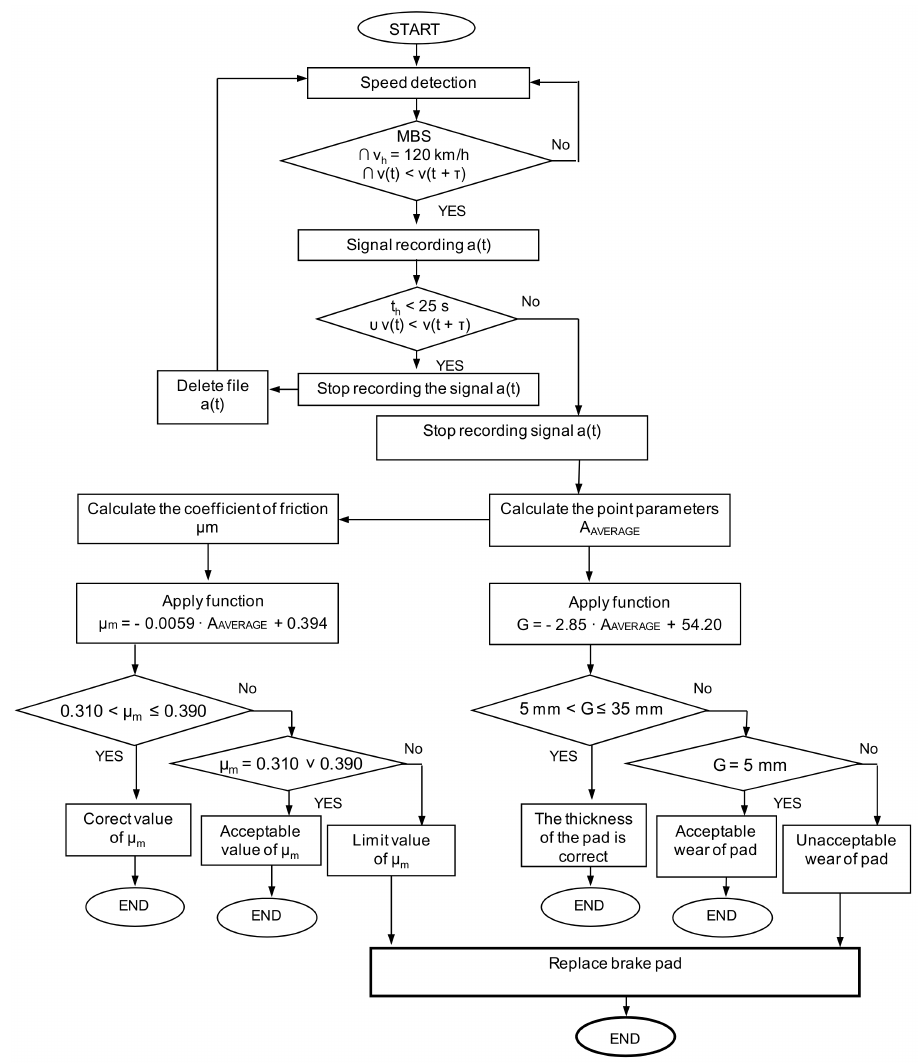
Figure 13. Algorithm of wear evaluation and estimation of the average coefficient of friction during braking at v = 120 km/h; MBS—perform service stopping braking, τ —increase of the braking